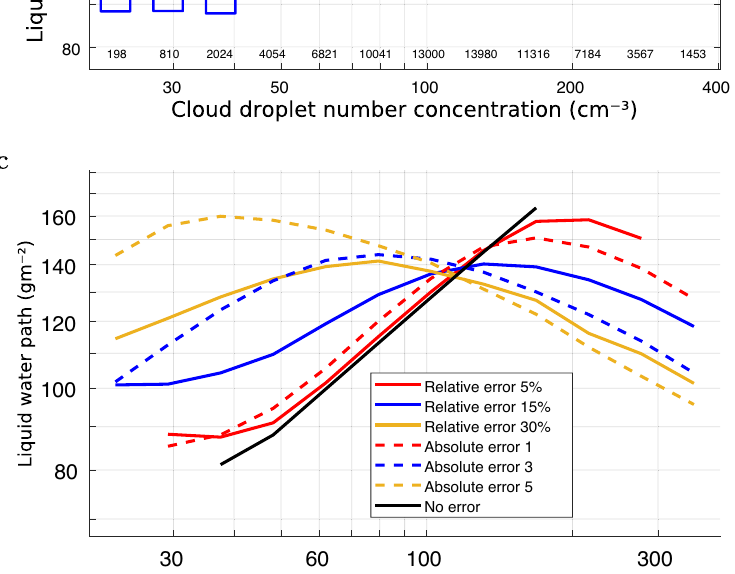
(dlnLWP/dlnCDNC). b The box-plot of the same results shown in panel a . The red dots show the mean, blue horizontal lines show the median and the box height is determinedbythe fi rstandthirdquartiles. c Medianvaluesresultingfromvarying levels of relative/absolute error. Unit of absolute CER error is μ m and absolute COD error is